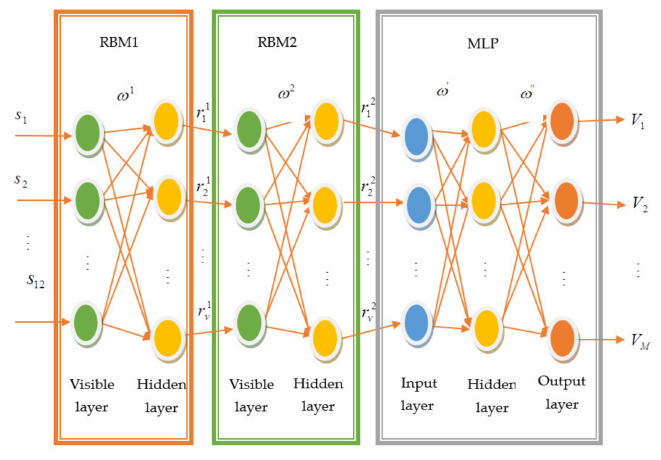
Figure 2. Architectural view diagram of DBN